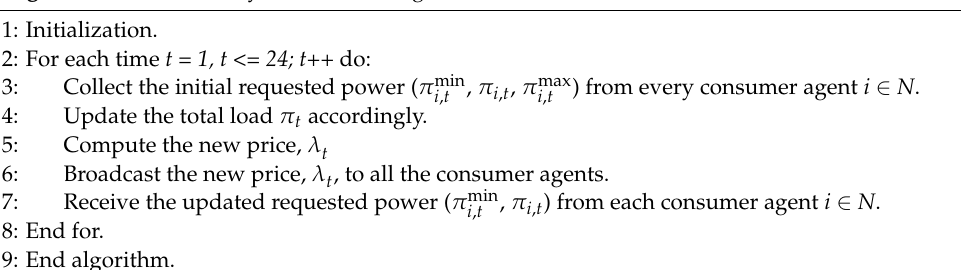
Power Min Power Max Power consumed Generated Power Figure 3. Comparison between the consumed and generated power as well as the minimum and the maximum power. 4.2. Distributed Control for Demand Response Distributed control is a method of demand response that uses distributed systems (such as smart meters) to manage energy usage. This system allows customers or utilities to monitor and adjust energy usage on an individual basis, rather than relying on a centralized system. This allows customers or utilities more flexibility in managing their own energy consumption and provides incentives for customers who reduce their energy use during peak times. In distributed DR, the request for energy is not centrally collected, and consumers have direct access to grid state indicators. Using this data, users can respond based on the system’s state, especially in crucial situations. At the round t (time) of information transmission between agents, let be , i t π the amount of resource sought by the agent i [29,30].